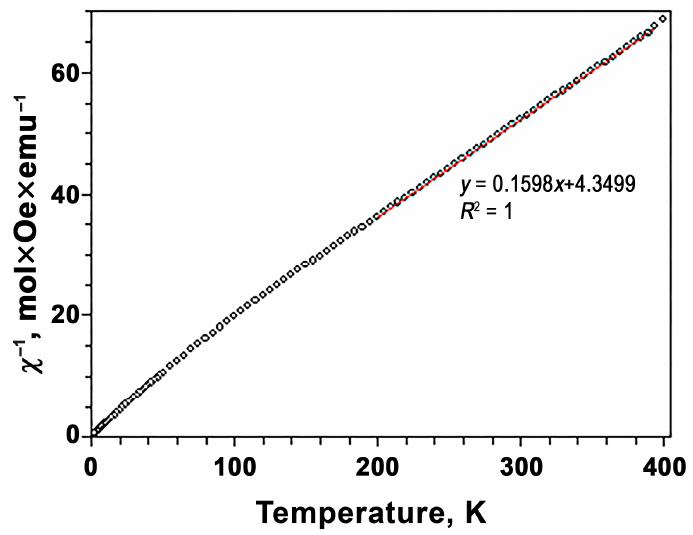
Figure 7. Temperature-dependent inverse magnetic susceptibility curve of Ca 8 MnEu(PO 4 ) 7 at H = 10 kOe with fitting results (line).